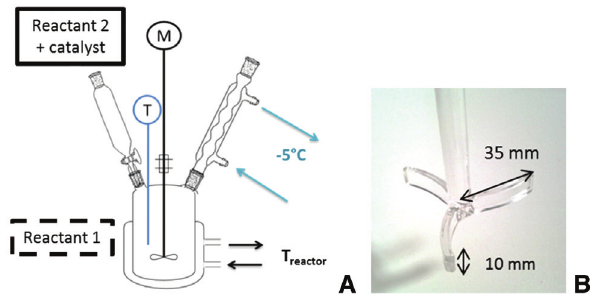
Figure 1 Schematic diagram of (A) the batch reactor that is used as the reference technology and (B) the curved bladed paddle